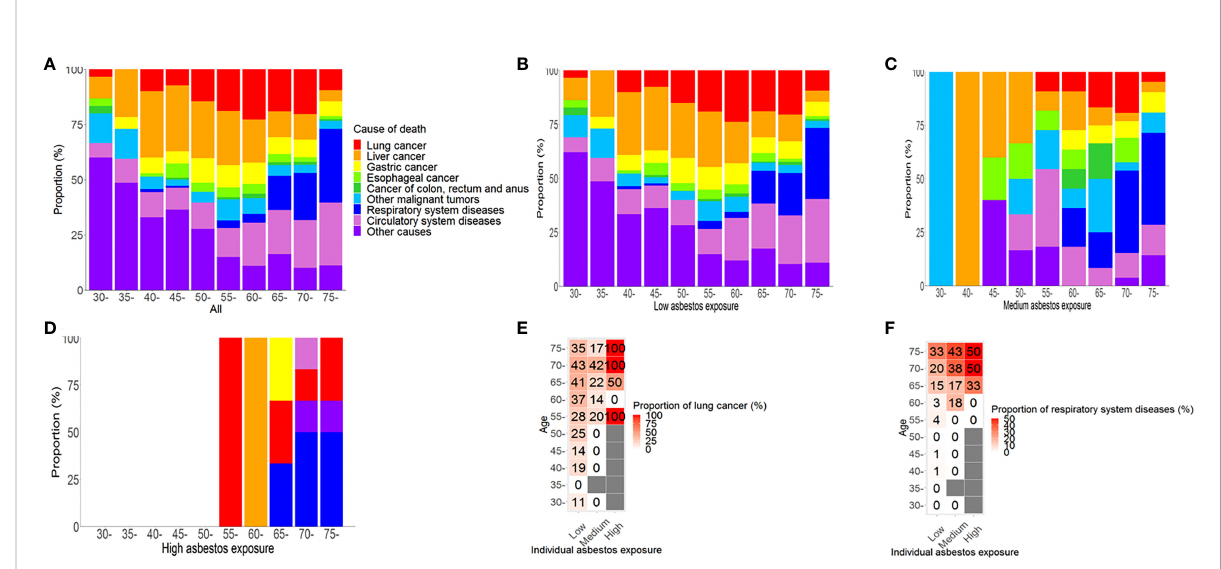
FIGURE 2 Causes of death by asbestos exposure level and age group among males. (A) Proportions of causes of death in all males; (B) Proportions of causes of death among males with low asbestos exposure; (C) Proportions of causes of death among males with medium asbestos exposure g; (D) Proportions of causes of death among males with high asbestos exposure; (E) Proportion of individuals who died from lung cancer in subgroups of each cross table among males; (F) Proportion of individuals who died from respiratory system disease in subgroups of each cross table among